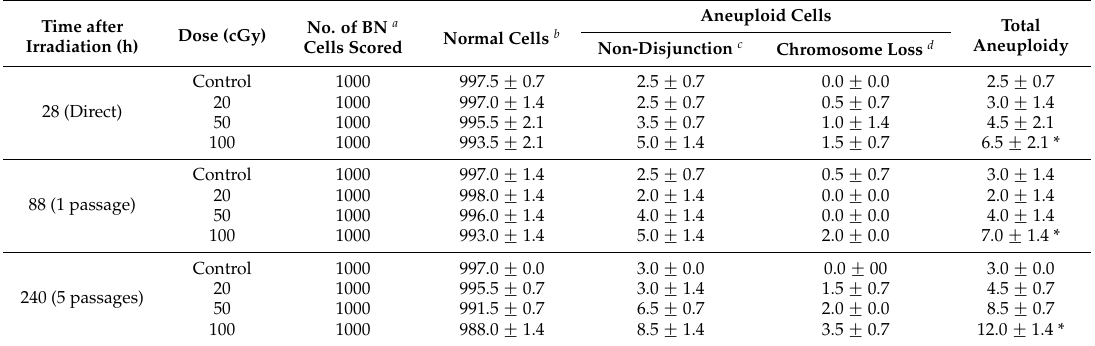
Table 3. The frequency of different types of aneuploidy in chromosome 4 from X-irradiated fibroblasts. Time after Dose No. of BN a Cells Normal Irradiation (h) (cGy) Scored Cells b